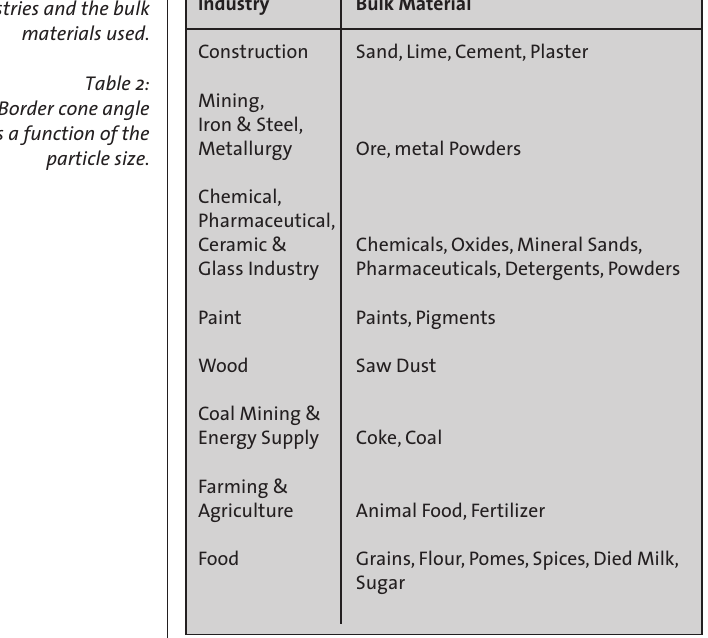
Table 1 (left): Industries and the bulk materials used. Table 2: Border cone angle as a function of the particle